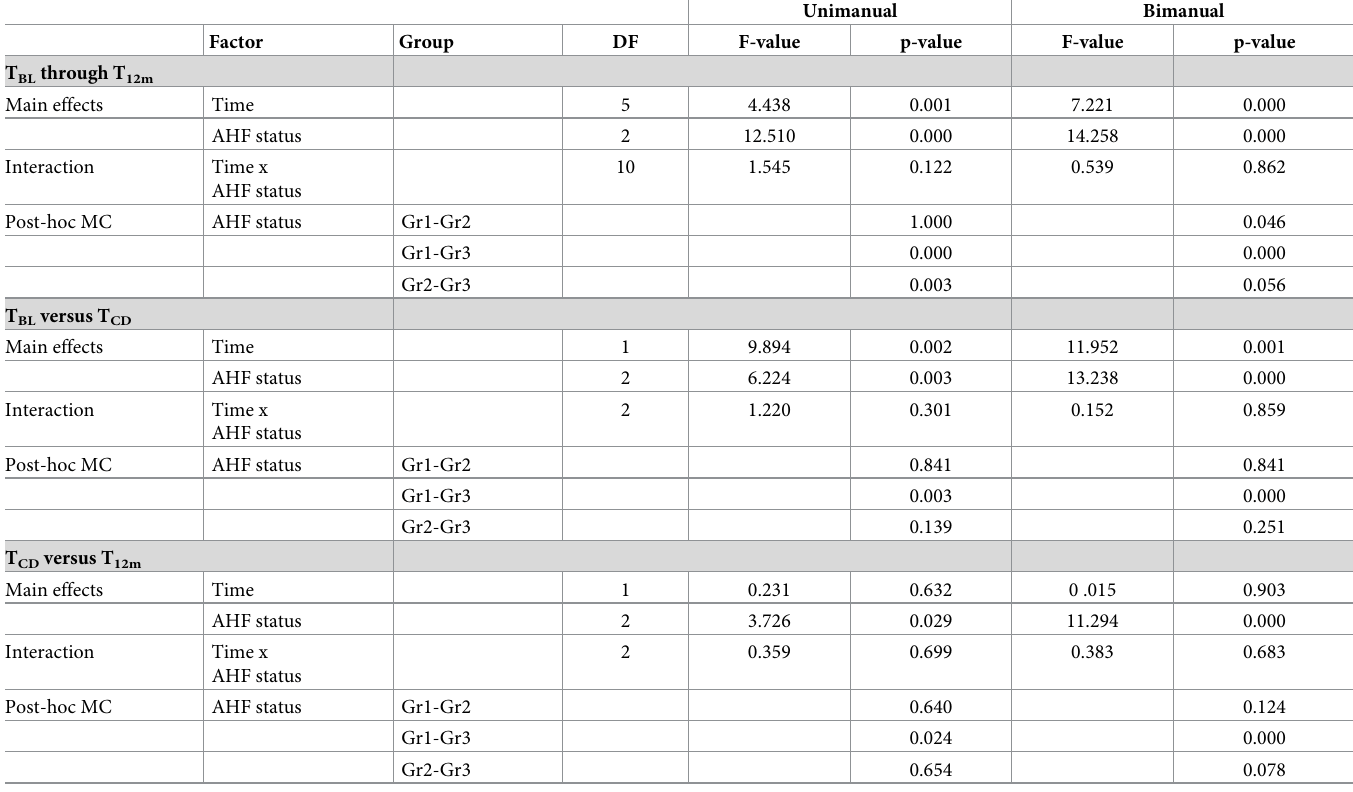
Table 3. Statistics regarding